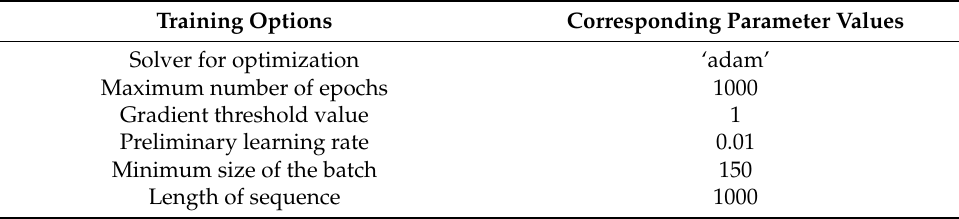
Table 3. Training options and the associated parameter values.